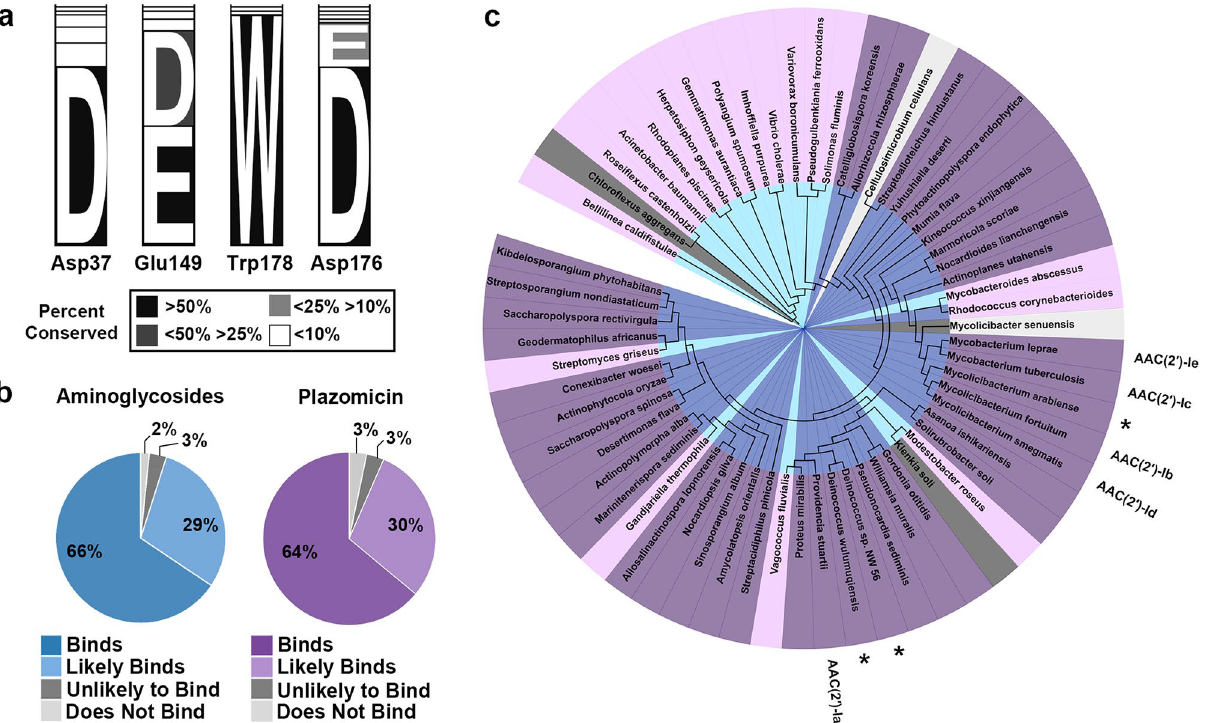
Figure 5. Phylogenetic analysis of aminoglycoside (2 ′ )-N-acetyltransferase substrate specificity. ( a ) Percent conservation of key residues involved in aminoglycoside and plazomicin binding, where conservation is colored according to the legend. ( b ) Predicted classification of 61 identified sequences as binders, likely binders, unlikely binders, and non-binders for aminoglycosides or plazomicin, colored according to the legend. ( c ) Phylogenetic tree of identified sequences colored as in panel ( b ), with aminoglycosides’ coloring in the center, and plazomicin coloring in the outer circle. The original five query sequences are labelled, and plasmid-encoded sequences are highlighted with an asterisk